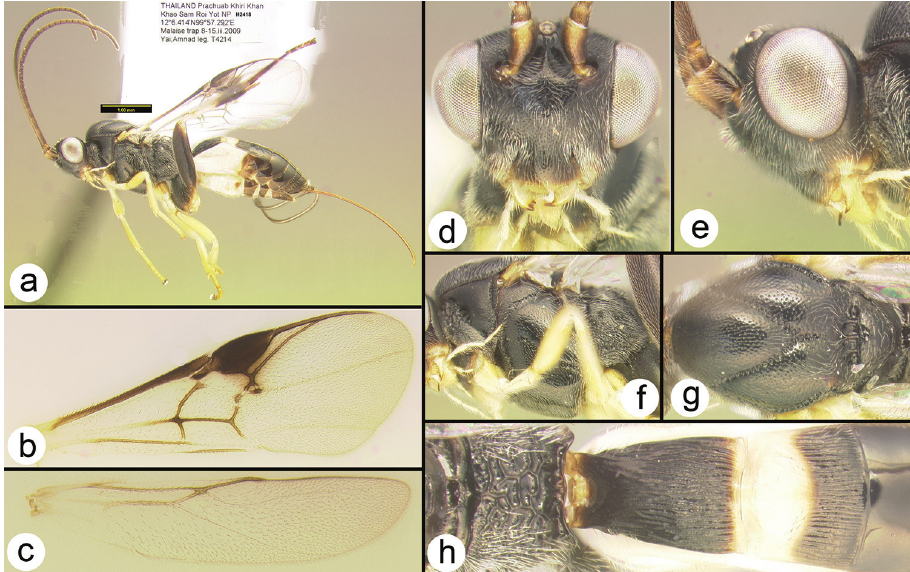
Figure 18. Z. samensis : a lateral habitus b fore wing c hind wing d anterior head e lateral head f lateral mesosoma g dorsal mesoscutum h propodeum and median tergites